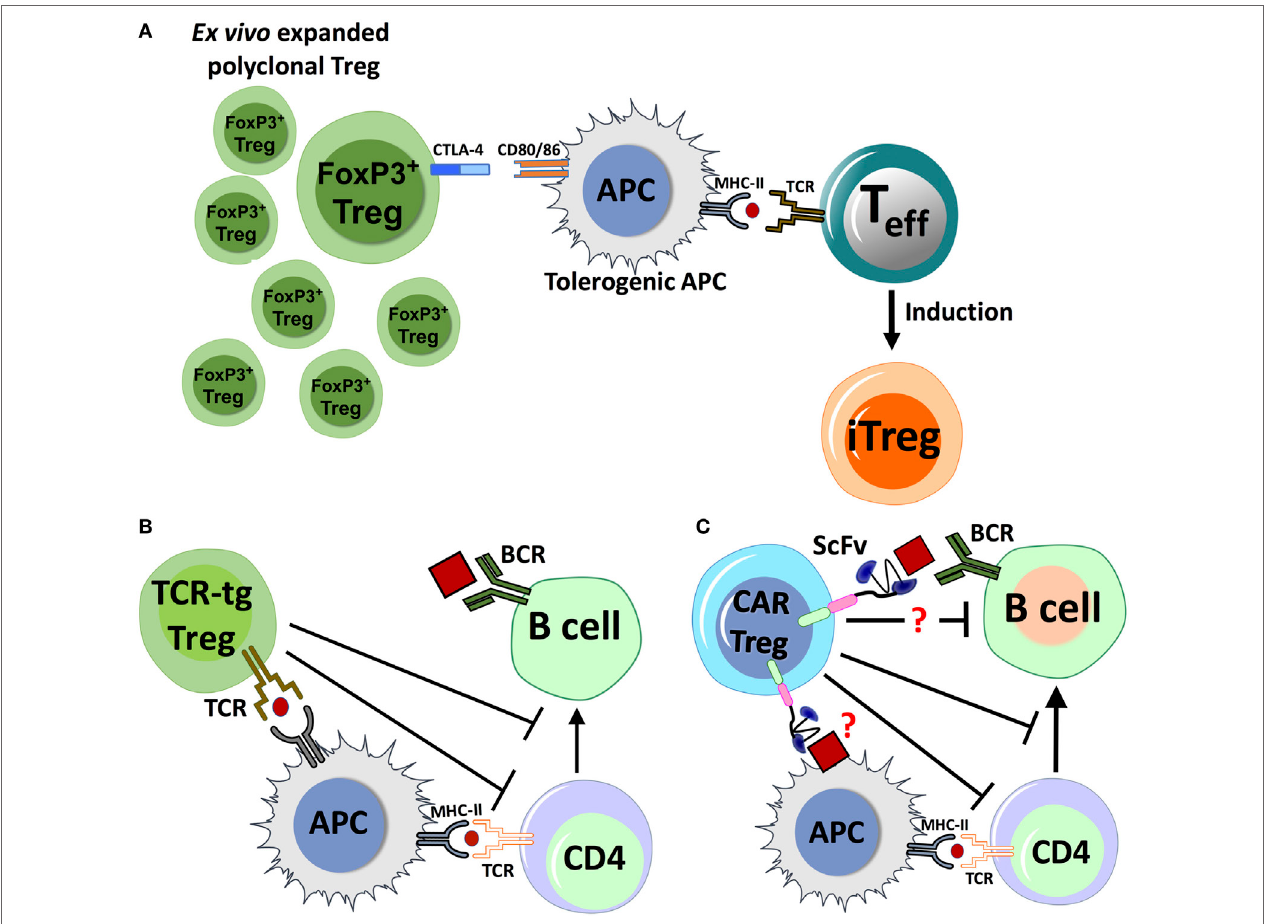
FiGURe 2 | Proposed mechanisms for immune suppression by adoptive transfer of polyclonal FoxP3 + regulatory T cell (Treg), chimeric antigen receptor (CAR)-Treg or TCR-transgenic (TCR-tg) Treg. (A) Adoptively transferred ex vivo expanded Treg with polyclonal specificity can interact with antigen-presenting cell (APC). Inhibitory receptors like CTLA-4 can compete with the costimulatory molecule CD28 to bind to CD80/86 receptors, and combined with other factors, it can lead to APC tolerization. Tolerogenic APCs interact with activated antigen-specific T effector (T eff ) cells, which leads to conversion of T eff to induced Treg (iTreg). (B) Natural Treg engineered with TCR specificity for antigen (TCR-tg Treg) can recognize antigen presented by APCs, directly suppressing the APC’s capacity to costimulate T eff cells. TCR-tg Treg can also directly inhibit CD4 + T helper cells, which in turn affects T cell help to antigen-specific B-cells. (C) Putative mechanisms for antigen recognition and suppression by CAR-Treg. CAR-Tregs may recognize either a B-cell bound antigenic epitope or antigen on the surface of APC, which can trigger the activation and proliferation of the CAR-Treg through transmembrane and intracellular-signaling domains. The mechanisms by which CAR-Tregs exert their suppressive effects are not clearly defined, but may include interactions with key cell